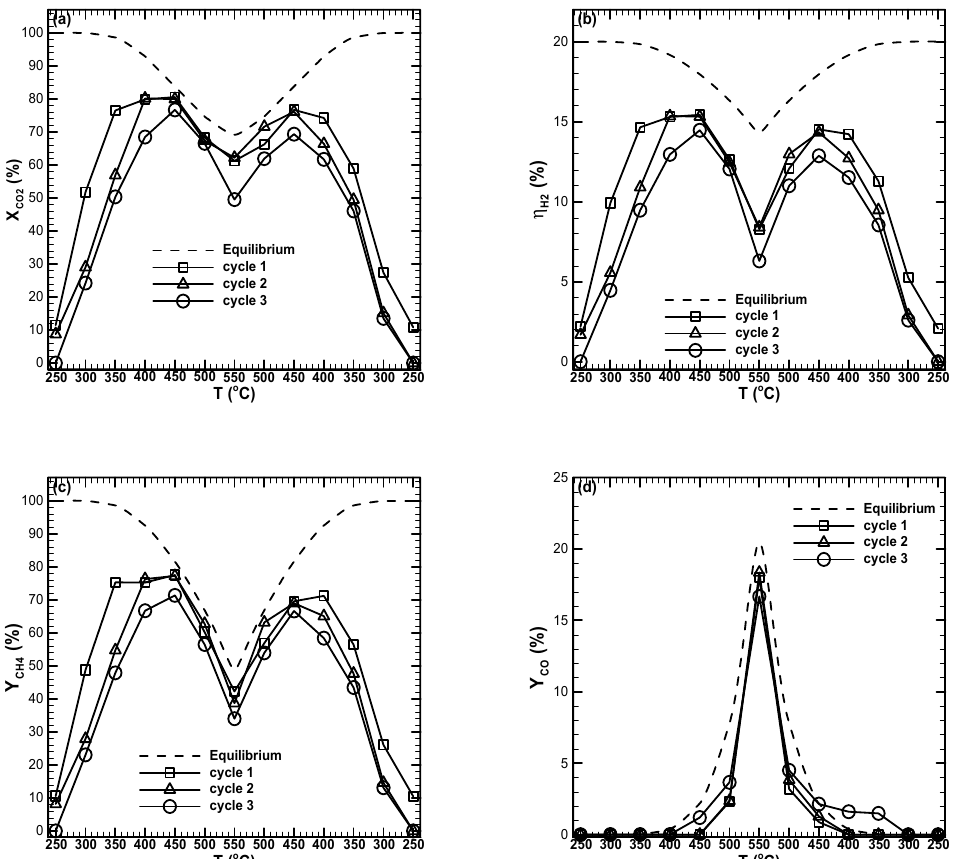
Figure 8. Thermal stability test of 1 wt% Ru–10 wt% Ni/Al 2 O 3 catalyst under three continuous ascending-descending temperature change cycles between 250 and 550 °C. ( a ) CO 2 conversion, ( b ) H 2 efficiency, ( c ) CH 4 yield, and ( d ) CO yield.